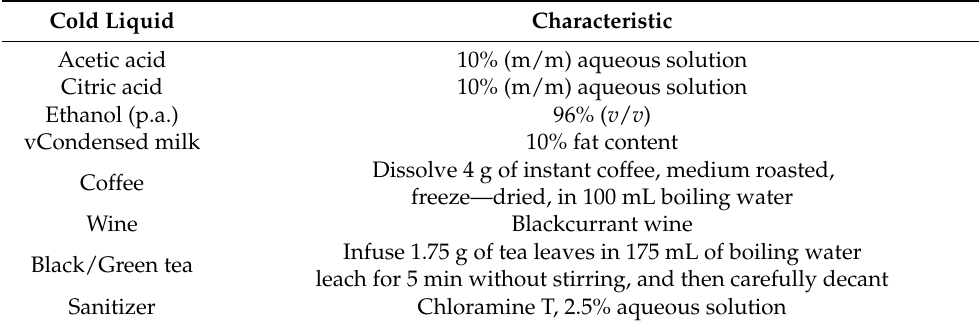
Table 4. Used cold liquids.